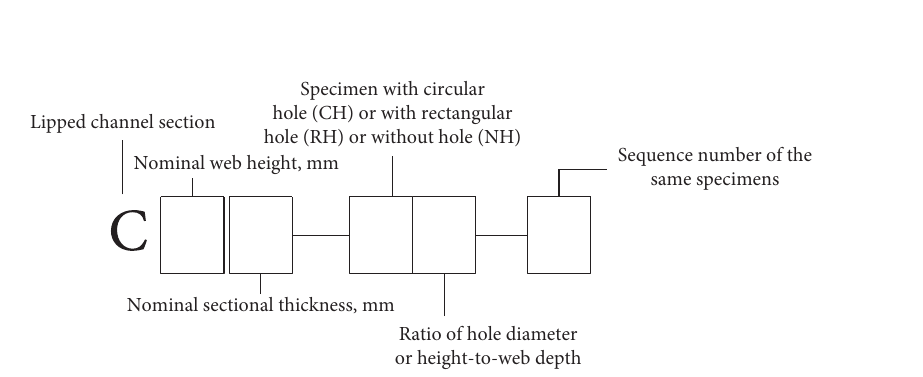
Figure 2: Stud column naming